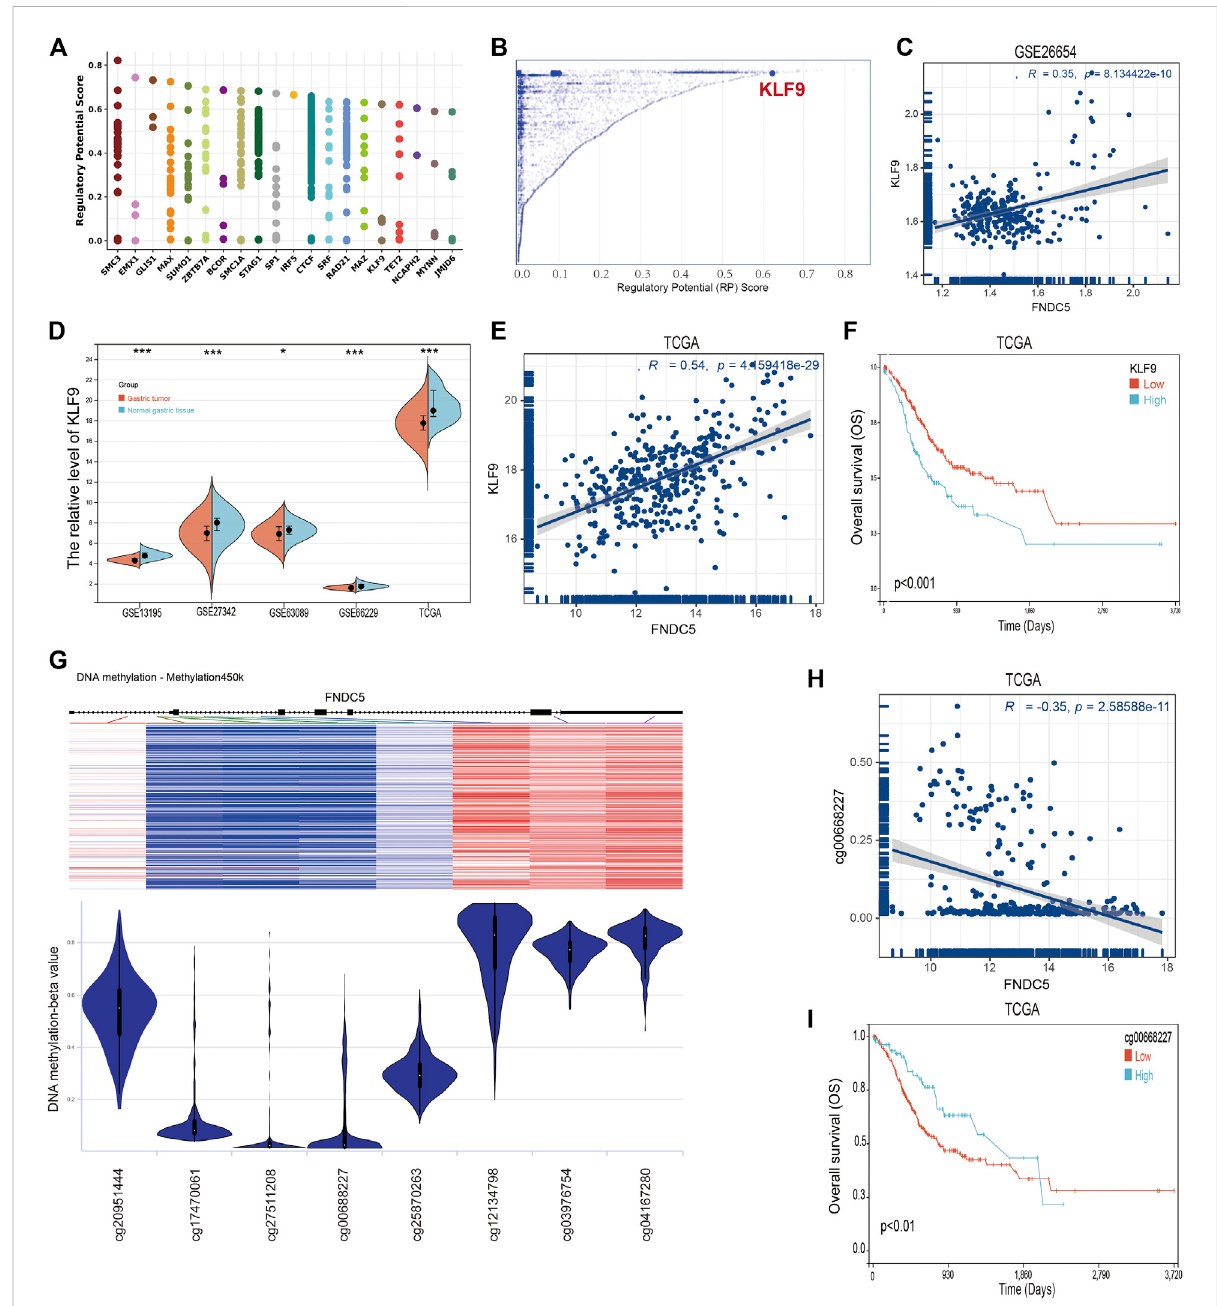
FIGURE 6 TFs and DNA methylation sites can regulate the expression of FNDC5. (A) Top 20 TFs likely to regulate FNDC5 in different human cancers. (B) TFs with high regulatory potential (10 k distance from TSS) (C) Correlation between FNDC5 and KLF9 mRNA expression in gse62254 database. (D) KLF9 expression in gastric cancer in fi ve mRNA datasets. (E) Correlation analysis of FNDC5 and KLF9 in gastric cancer patients. (F) OS analysis of KLF9 for gastric cancer patients in TCGA database. (G) Association of FNDC5 with DNA methylation in gastric cancer. (H) Association of FNDC5 with methylation site cg00668227. (I) OS analysis of methylation sites (cg00668227) for gastric cancer patients in the TCGA database. *, p < 0.05; ***, p <